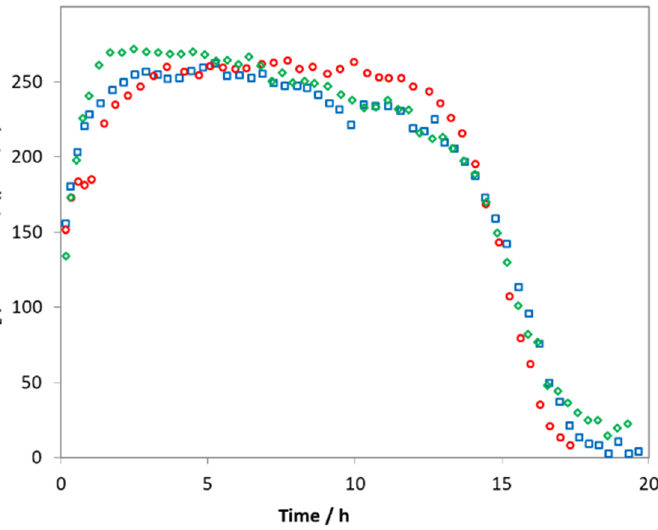
Figure 10. The rate of H 2 production of Cat-2N-pHx (x: 10 (green ), 11 (blue ), and 12 (red ) as functions of time from a 0.13 M Na 2 S/0.18 M Na 2 SO 3 solution.